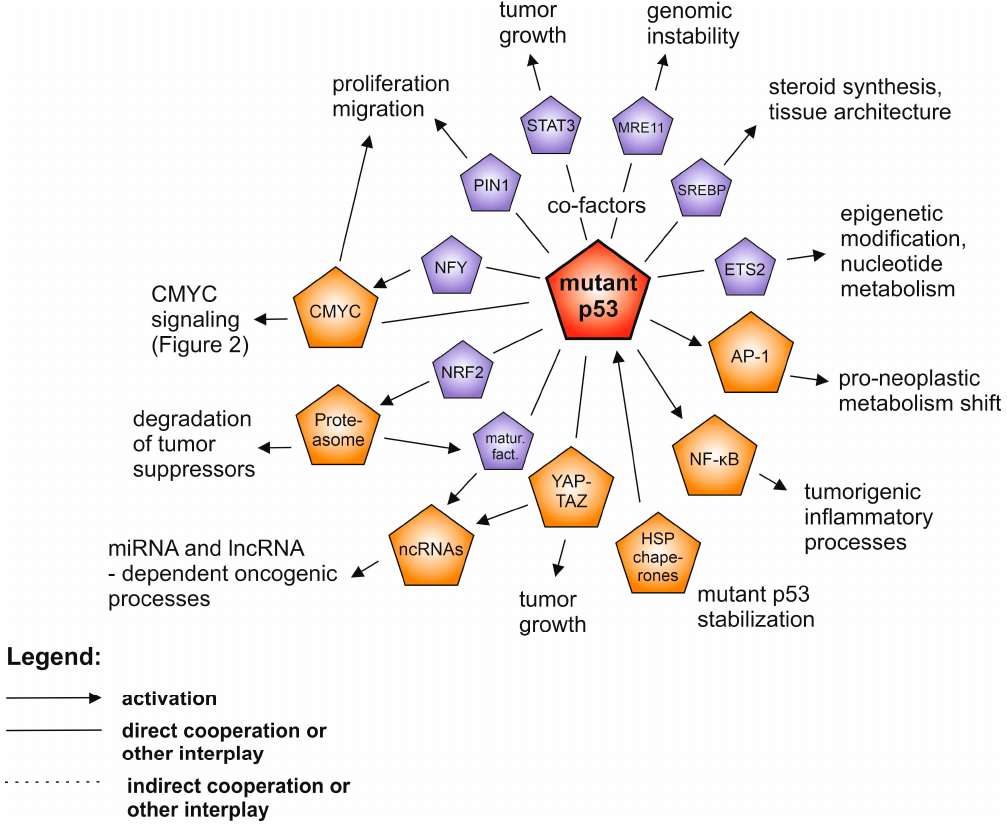
Figure 1. The network of the interplay between mutant p53 (highlighted in red) and other oncogenic drivers in human neoplasia. The drivers described in separate paragraphs are shown in orange, while additional oncoproteins are shown in purple. Only the selected and well supported connections are shown, as described in the